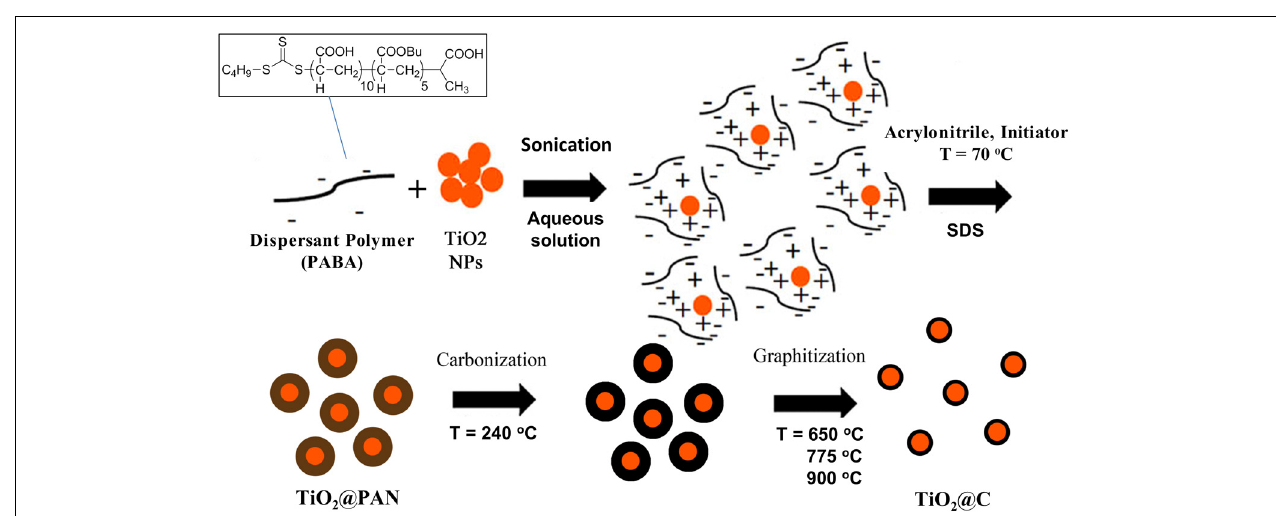
The second step is an emulsion polymerization process resulting in the formation of a layer of polyacrylonitrile. The third or fourth steps are respectively carbonization and graphitization steps, whereby PAN is converted in